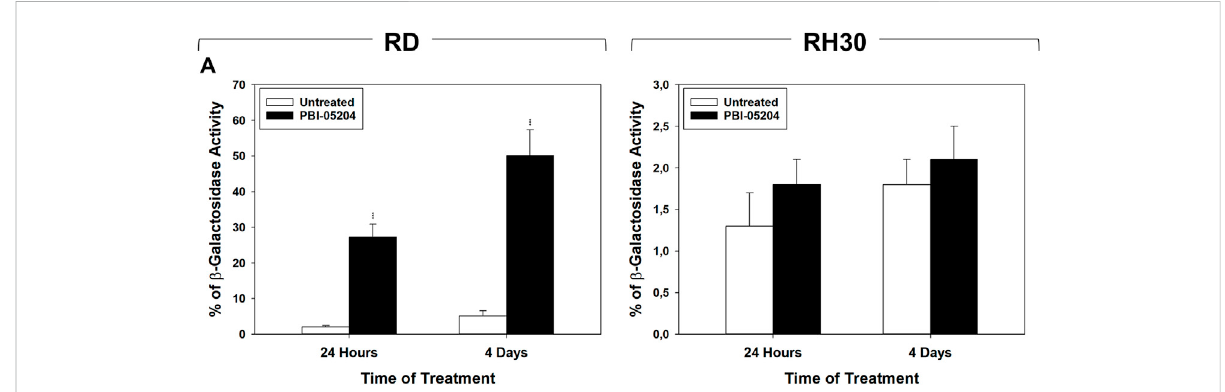
FIGURE 3 PBI-05204 induces senescence in FN-RMS but not in FP-RMS cells. (A) b-Galactosidase test performed on RD (Left) and RH30 (Right) cells untreated or treated for 24 h and 4 d with PBI-05204 (IC 50 ). Data represent the mean value of three independent experiments ±SD.